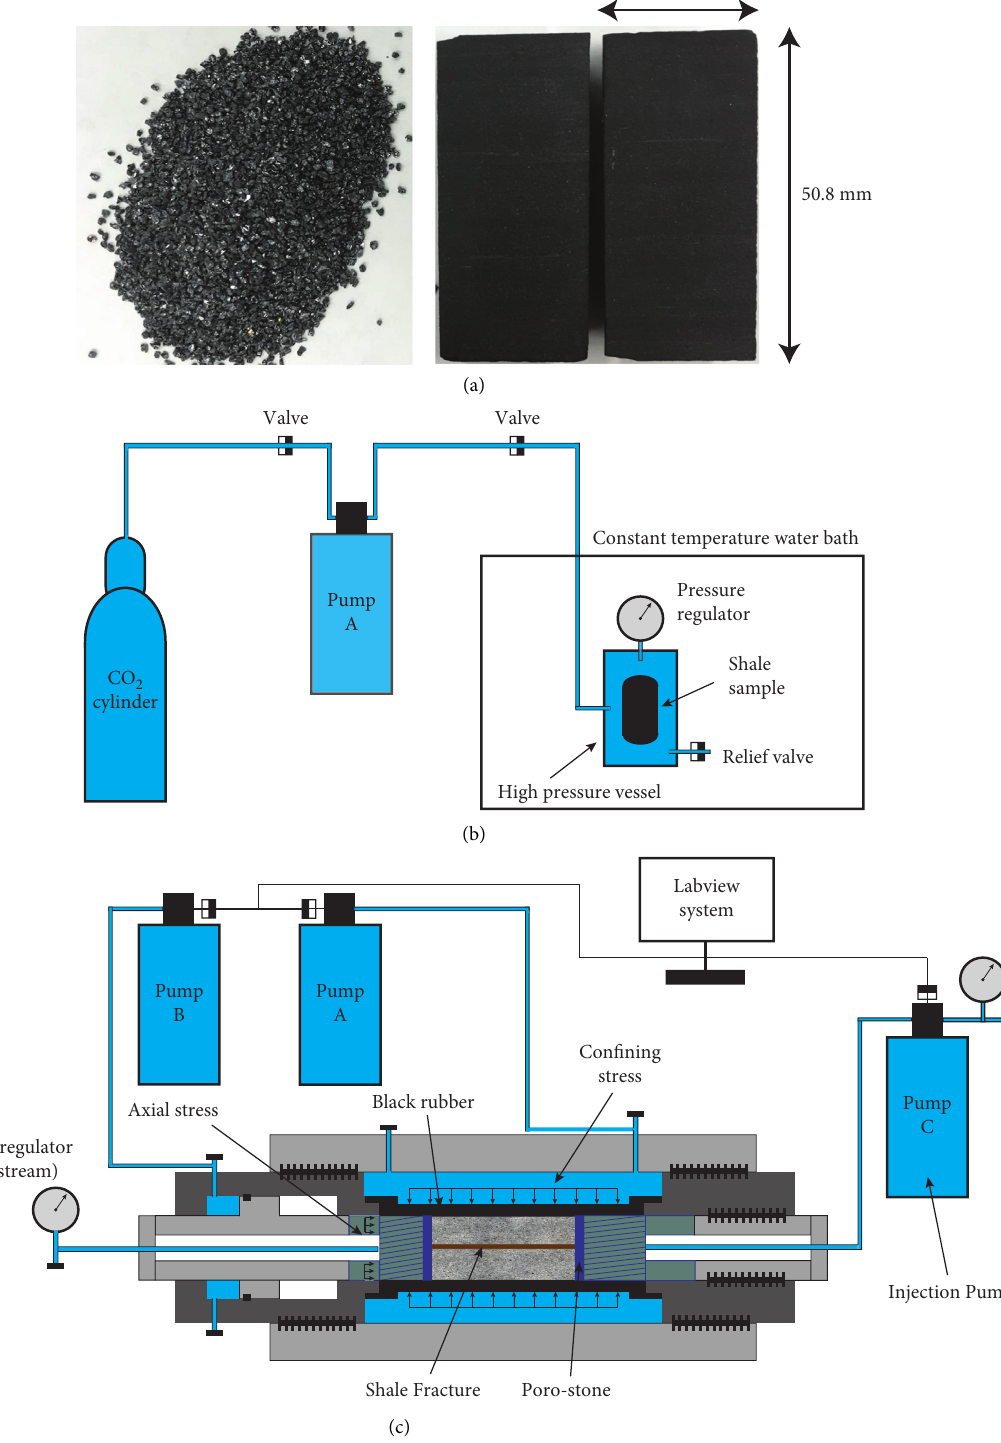
Figure 1: (a) The Longmaxi shale samples used for the tests. (b) The experimental apparatus for the CO measurement